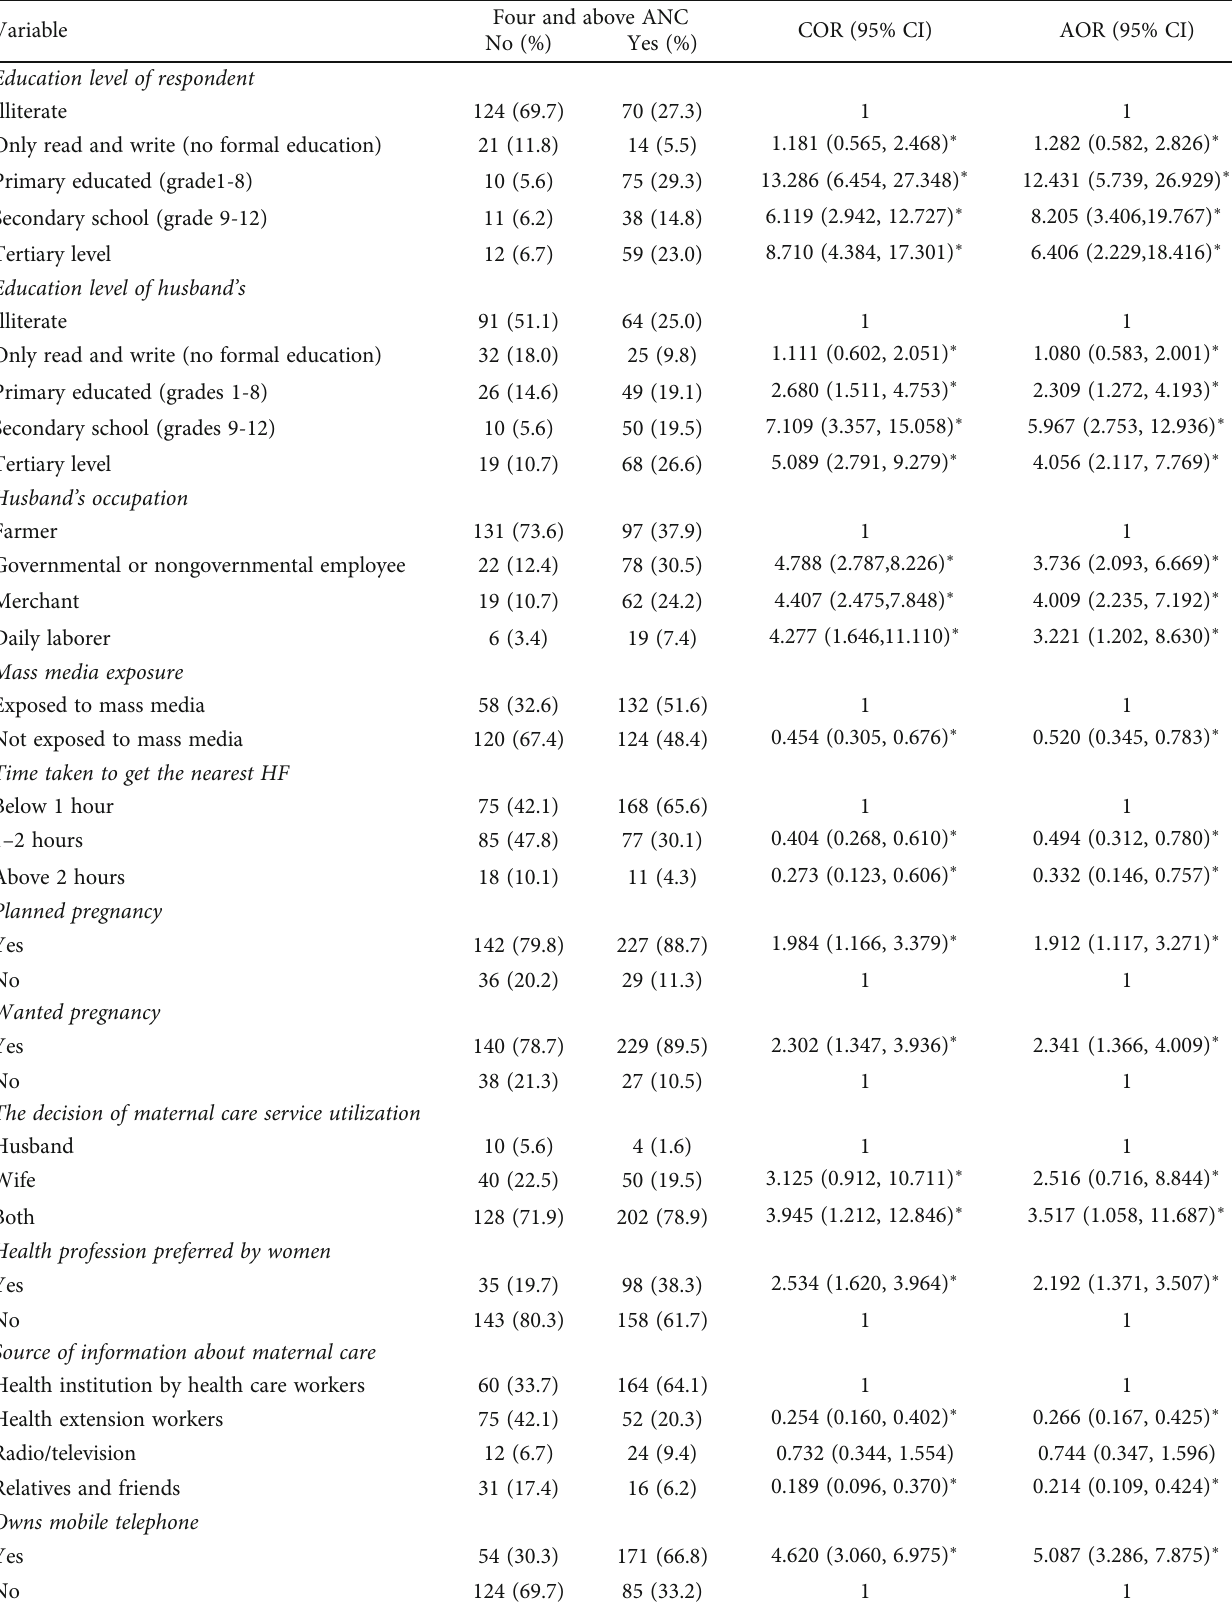
Table 4: Factors associated with four or more antenatal care (ANC) visits in the South Gondar Zone.